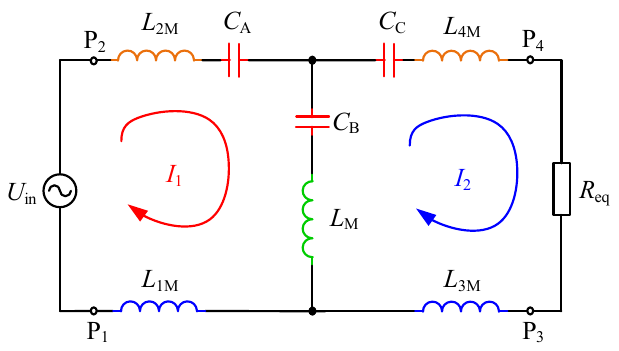
Figure 4. System π -type model.